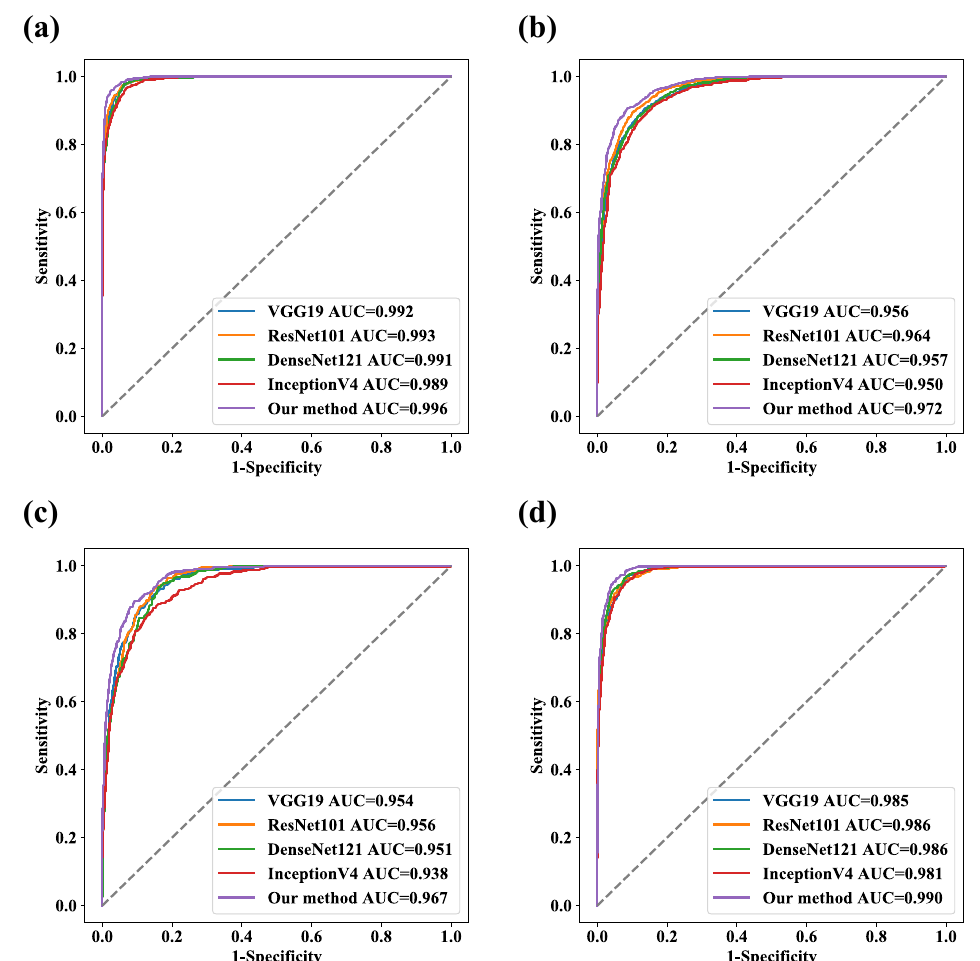
Figure 8. ROC curves for five models. ( a ) MES 0, ( b ) MES 1, ( c ) MES 2, and ( d ) MES